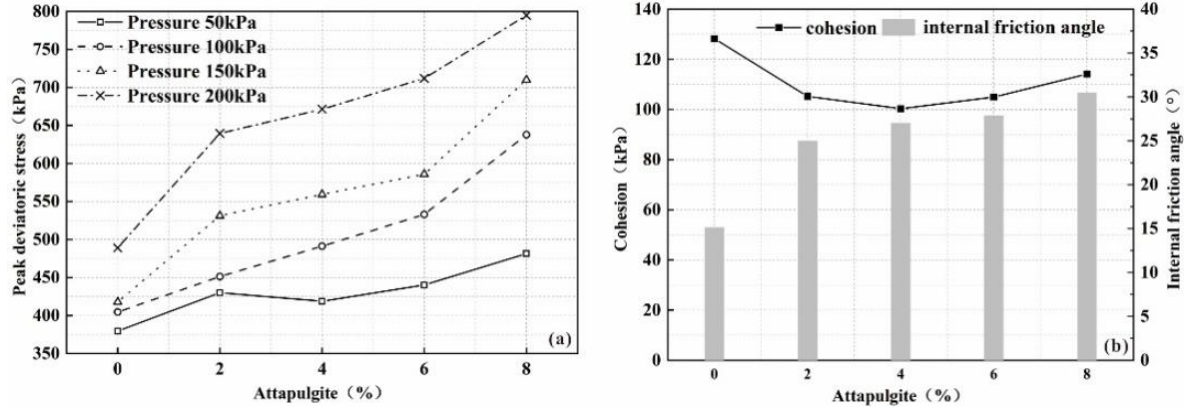
Figure 5. ( a ) The peak deviatoric stress; ( b ) cohesion and internal friction angle varied with atta- pulgite replacement.